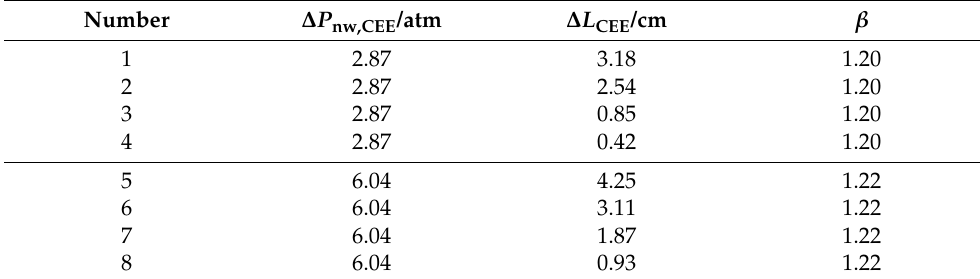
Table 8. Stability factor calculation